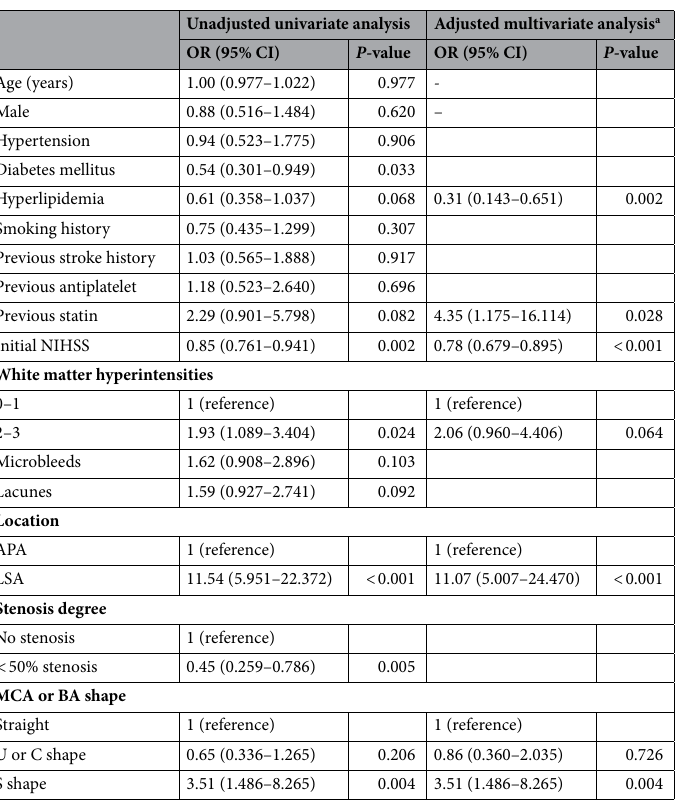
Table 3. Factors associated with LD. Results are presented by OR (95% CI). LSA: Lenticulostriate arteries, APA: Anterior pontine arteries, MCA: middle cerebral artery, BA: basilar artery, LD: lipohyalinotic degeneration; NIHSS: National Institutes of Health Stroke Scale. a Multivariate logistic regression adjusted for age, sex, initial NIHSS, Diabetes mellitus, Hyperlipidemia, Previous statin, location, stenosis degree and MCA or BA